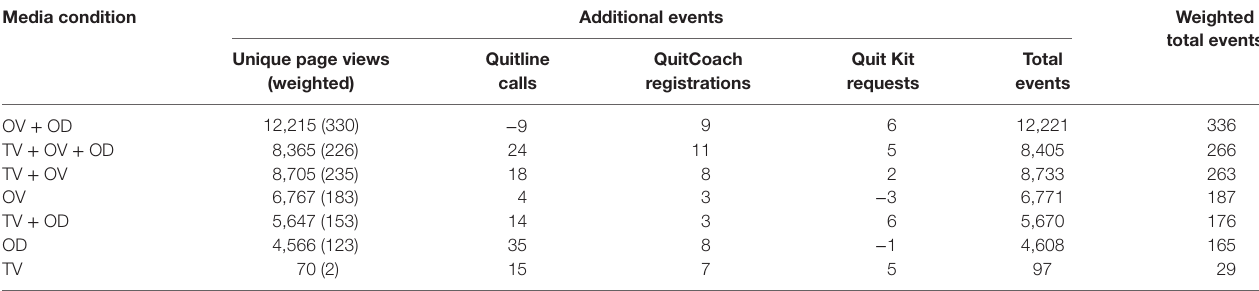
taBlE 3 | Additional events recorded for each media condition.